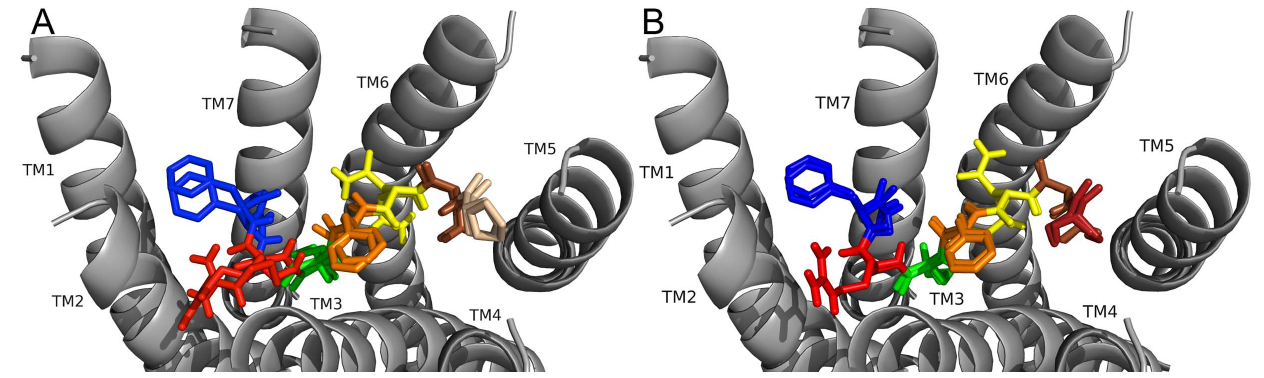
Figure 6. PDNFMRF-NH 2 and SDNFMRF-NH 2 docked to FMRFa-F. PDNFMRF-NH 2 docked to FMRFa-R (see A). Contacts made between the amino acids in PDNFMRF-NH 2 are shown as P (tan), D (brown), N (yellow), F4 (orange), M (green), R (red), and F7 (blue) and the receptor, FMRFa-R, whose transmembrane regions are labeled TM # where # is 1–7. The C-terminal F was amidated, -NH 2 . SDNFMRF-NH 2 docked to FMRFa-R (see B). Contacts made between the amino acids in SDNFMRF-NH 2 are shown as S (brick red), D (brown), N (yellow), F4 (orange), M (green), R (red), and F7 (blue) and the receptor, FMRFa-R, whose transmembrane regions are labeled TM # where # is 1–7. The C-terminal F was amidated, -NH 2 . doi:10.1371/journal.pone.0075502.g006 PLOS ONE |